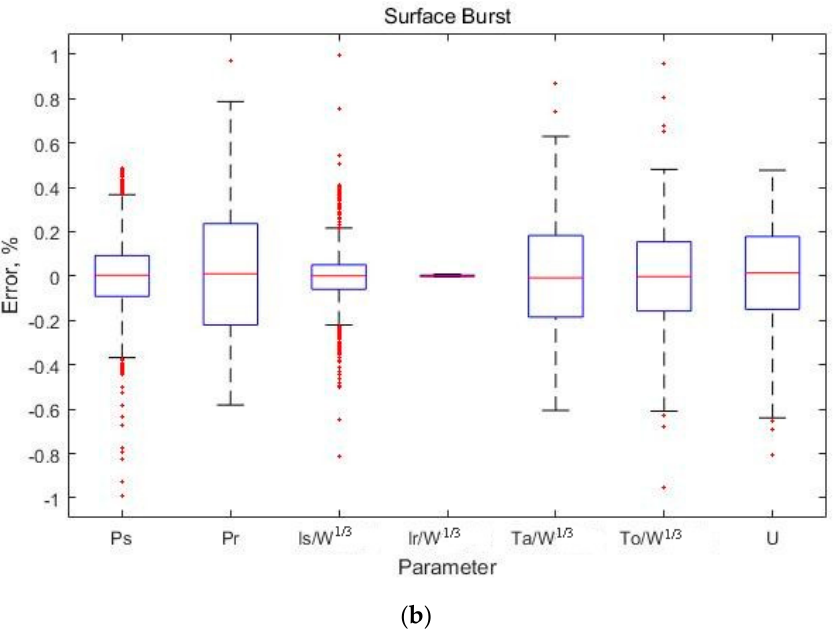
Figure 4. Error of modified equation (box plot): ( a ) Free-air burst; ( b ) Surface burst.